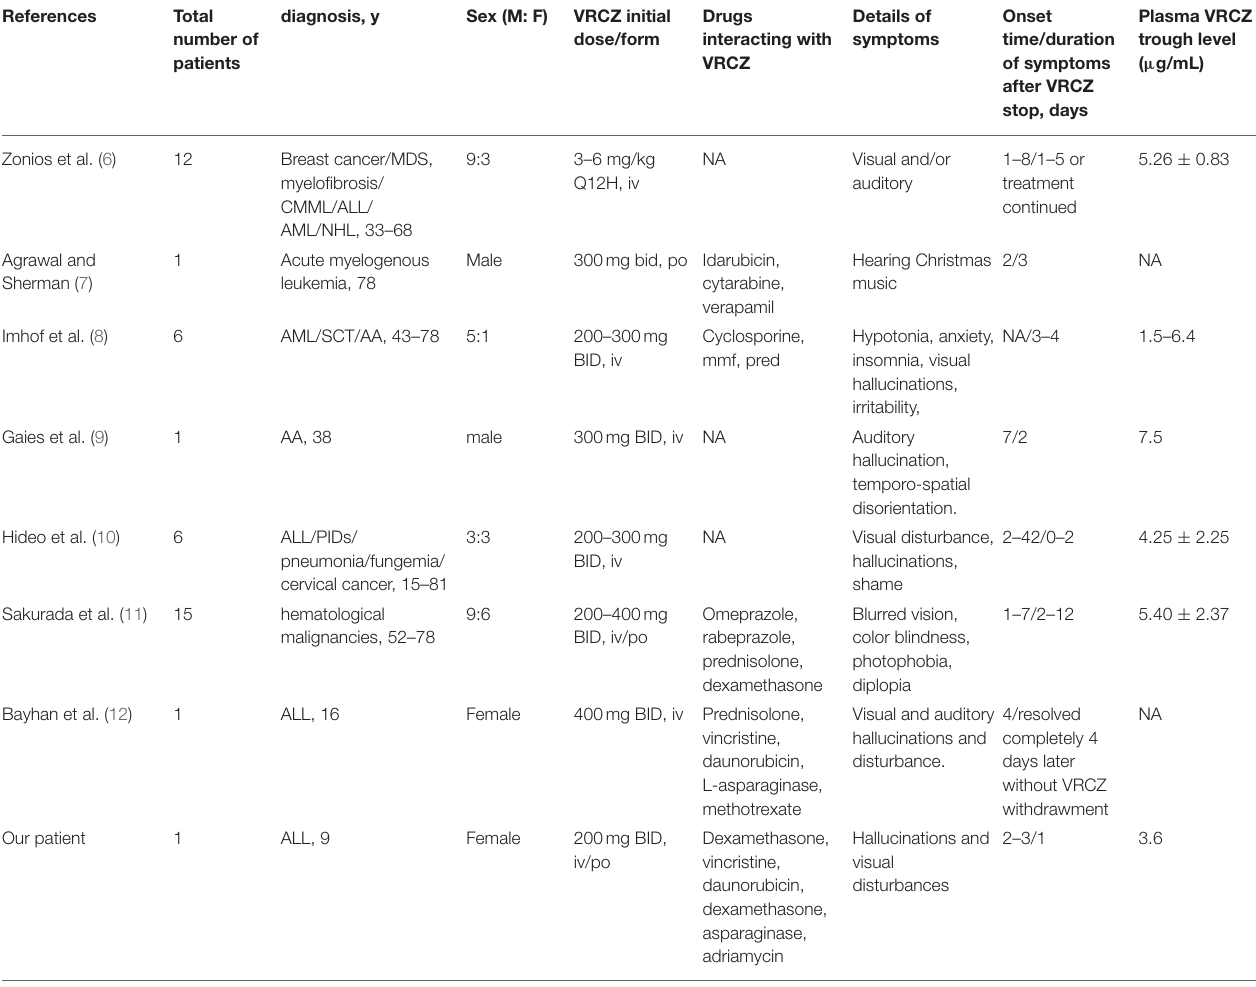
TABLE 1 | Literature review of voriconazole induced hallucinations and (or) visual disturbances.